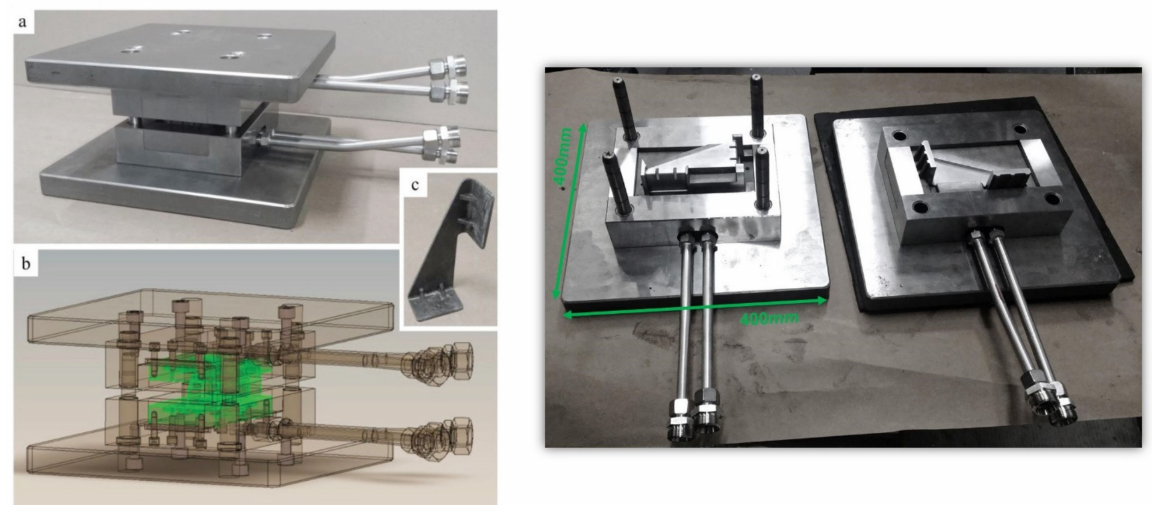
Figure 26. The selected modular tooling concept comprised standard tool rack with four guide pins made of hardened steel and a quick-change mold system manufactured by L-PBF. ( a ) the tool, ( b ) CAD model of the tool, and ( c ) carbon fiber SMC cleat